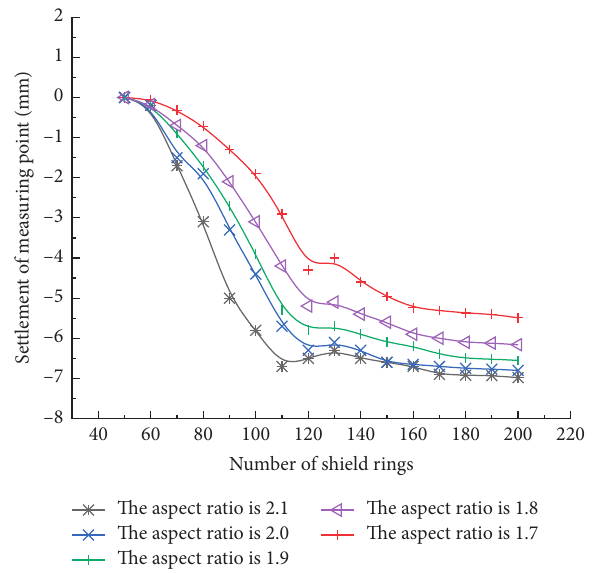
Figure 6: Effect of aspect